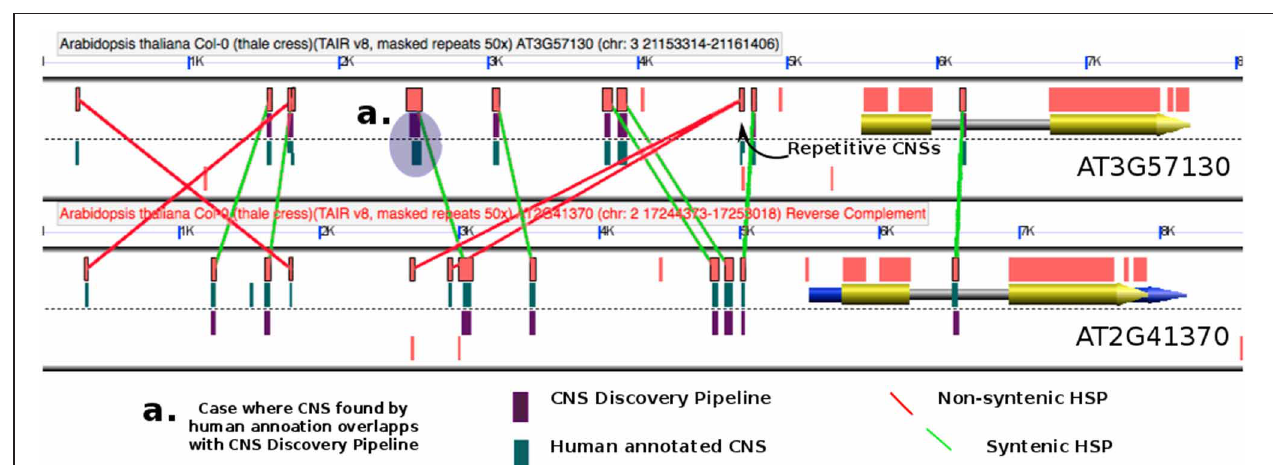
option in GEvo “Sequence Submission”) and green rectangles for CNS discovered manually. Previously identified CNSs are displayed by selecting the “show pre-annotated CNSs” option in GEvo. Illustrated are manual red lines for “CNSs” that are non-syntenic, and in masked regions and manual green lines for syntenic CNSs.Regenerate these data inGEvohttp://genomevolution. org/r/8ooz (Set reverse complement to achieve this